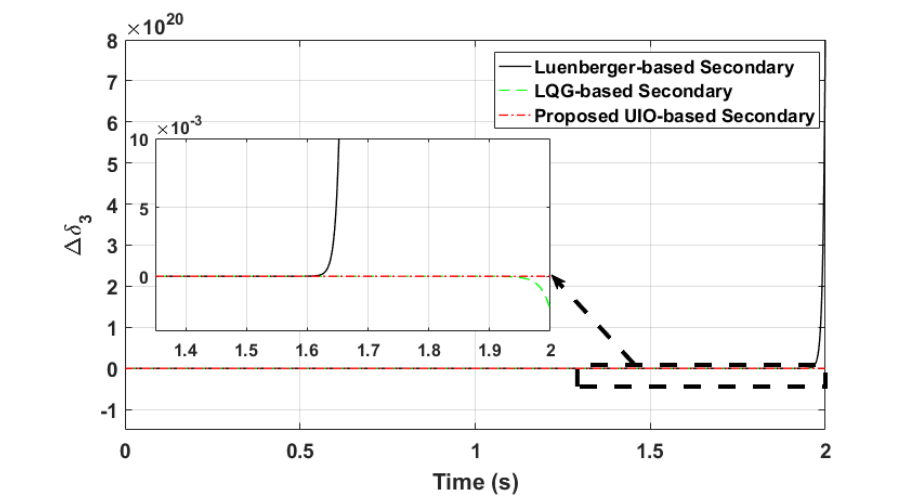
Figure 15. Third inverter angle δ 3 in scenario 3 (Stealthy FDI to second inverter’s actuator).